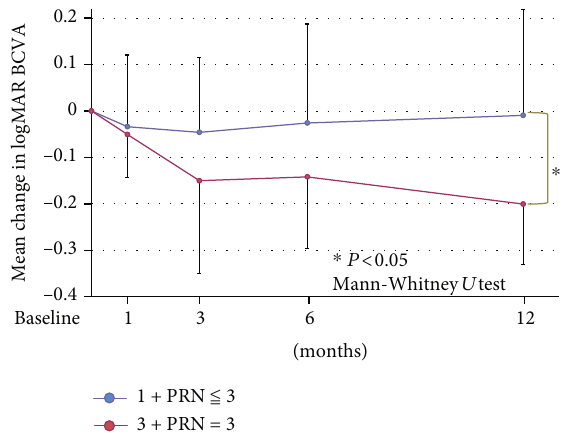
Figure 4: Changes in the mean BCVA from the baseline to 12 months after the IVA injections in eyes in which the mean total number of injections was < 4 times. In the 3+PRN group, the mean BCVA was signi fi cantly improved at 12 months after the IVA compared to that in the 1+PRN group ( P = 0 : 0013 , Mann- Whitney U test). BCVA: best-corrected visual acuity; PRN: pro re nata ; logMAR: logarithm of the minimum angle of